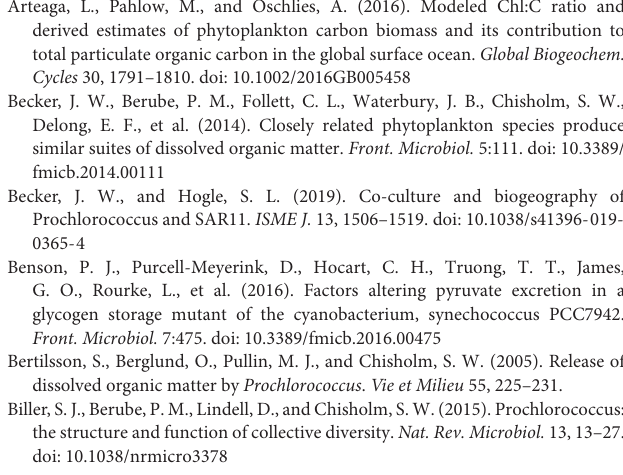
Supplementary Table 1 | List of reactions added to iJC568 to form iSO595. Supplementary Table 2 | List of reactions from iJC568 that are modified in iSO595. Supplementary Table 3 | Parameter ranges used in the sampling of nutrient environments. Supplementary Table 4 | List of blocked exchange reactions prior to sampling of nutrient environments. Supplementary Table 5 | Parameter values used to run dynamic FBA in COMETS. Supplementary Material 1 | Results from the BLAST-search used to identify 6PG-dehydratase (EC: 4.2.1.12) encoded by PMM0774 in P. marinus MED4. Supplementary Material 2 | Memote snapshot report of i